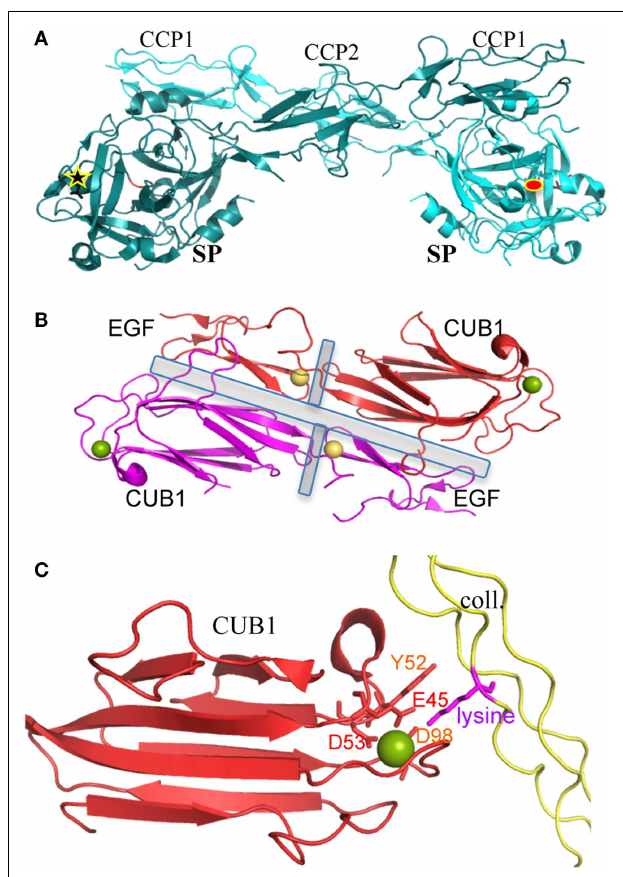
FIGURE 2 | Structures of key protein/protein interactions of C1 components . (A) Dimeric association of the C1r catalytic domains.The interface involves similar interactions between the SP domain and the CCP1 module, in both the pro-enzyme and active C1r catalytic domain structures.This typical “butterfly” shape can be recognized on some electron micrographs from the proteases tetramer (23).The 90Å distant active site (red ellipse) and activation site (black star) of the two molecules are highlighted [PDB code 1GPZ (36)]. (B) Dimeric CUB1–EGF interface (present in vitro in C1s homodimers and in vivo in C1r/C1s heterodimers). The central EGF calcium-binding sites stabilize both the inter- and intra-monomeric CUB-EGF interfaces (highlighted by gray rectangles). Since interface residues are mostly conserved in C1r (compared to C1s), we can assume that this head-to-tail packing observed with C1s homodimers also stands for the C1s–C1r heterodimer.This typical shape can also be recognized on some rare electron micrographs performed on the proteases tetramer (23).Yellow sphere, calcium in EGF; green sphere, calcium or magnesium in the C1s CUB1 module [PDB code 1NZI (45)]. (C) Calcium-dependent interaction between C1s CUB1 module and a lysine-containing collagen-like peptide [PDB code 4LOR (5)].The main structural determinants are highlighted.The lysine side chain directly interacts with Glu45, Asp98, and Ser100. Asp53 is an essential component of the calcium-binding site. Mutations of Glu45,Tyr52, and Asp98 strongly alter C1q-binding properties [reviewed in Ref.